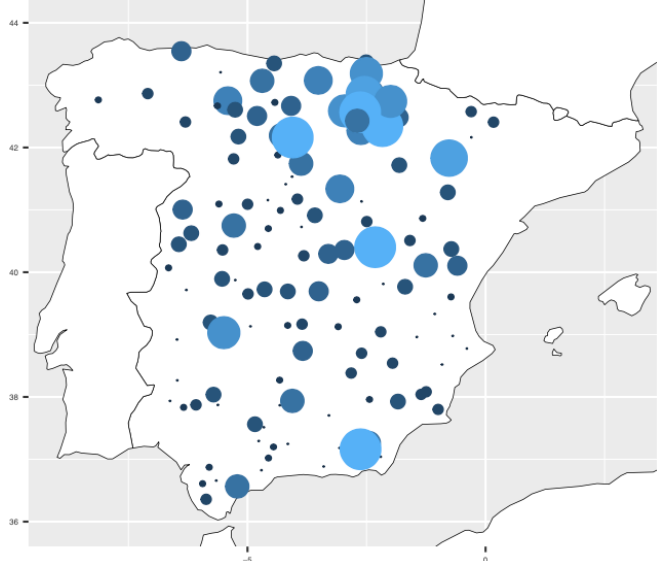
Figure 1. Geographical spread of ‘masque’ (Locations with >5 tokens